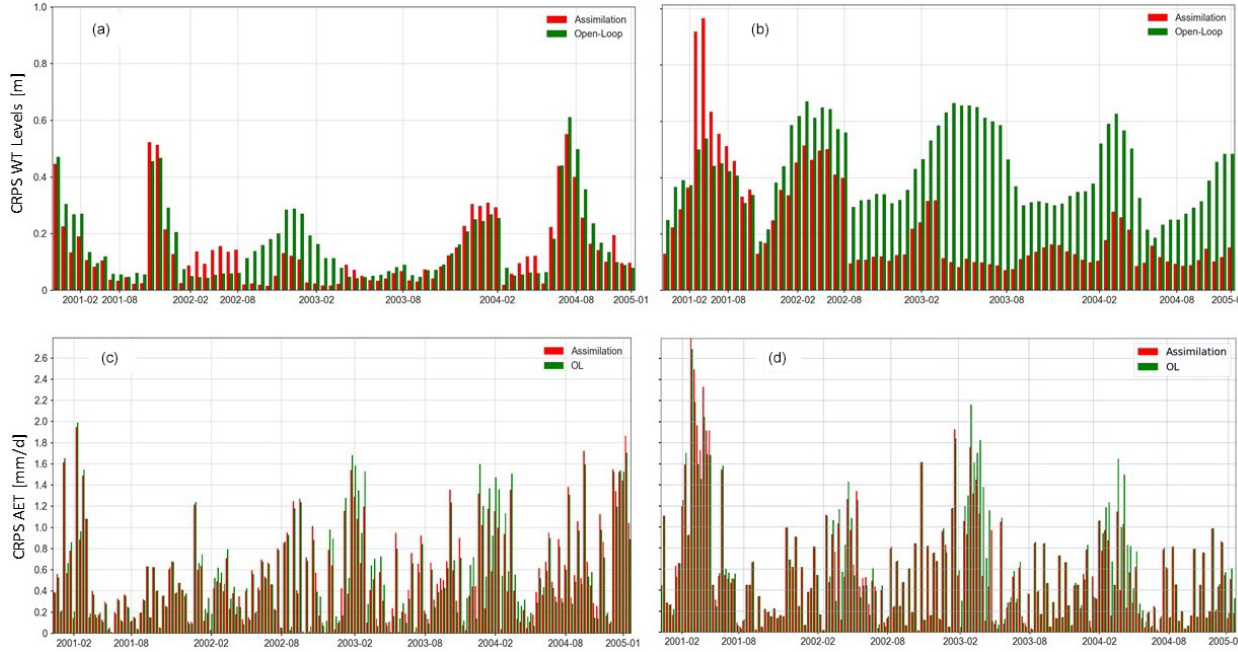
Figure 8. CRPS WT levels and AET for Configuration-1 (a, c) and Configuration-2 (b, d)